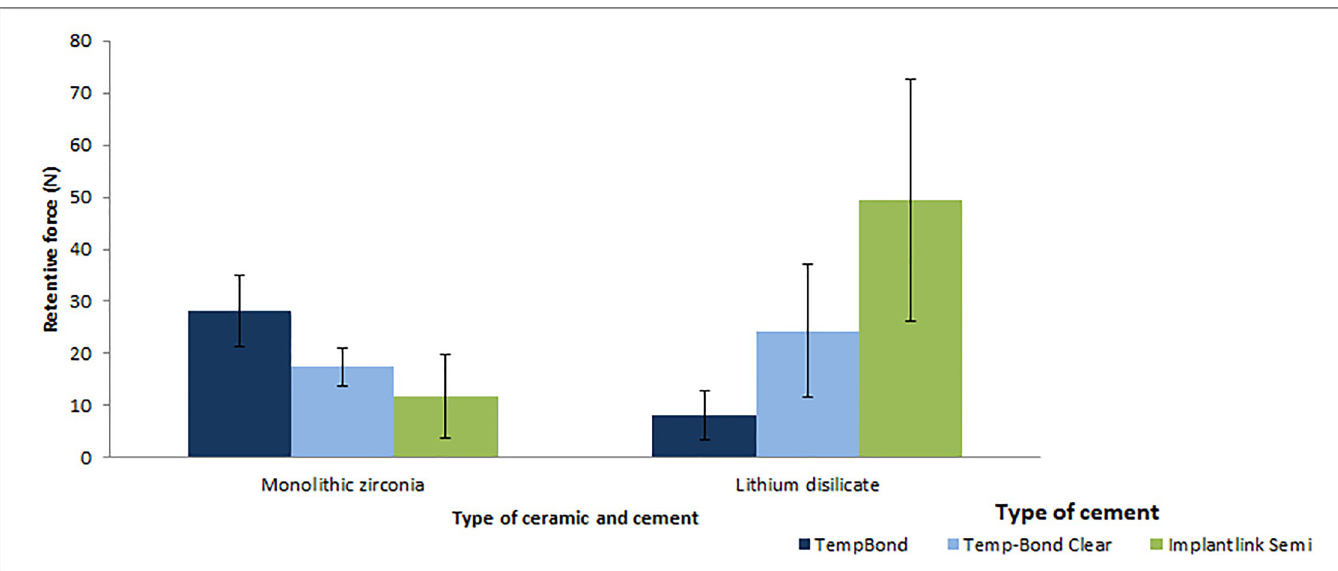
Fig 4. The mean and standard deviation of retentive strength of cements as a function of the type of restorations. Concerning the effect of ceramic restoration, the mean retention was significantly different between the two ceramic types only when cemented with TempBond ( P < 0.001) and Implantlink Semi cement ( P = 0.004); that is, the mean retentive strength of TempBond was significantly higher in monolithic zirconia restorations; while in lithium disilicate, Implantlink Semi was more retentive (Table